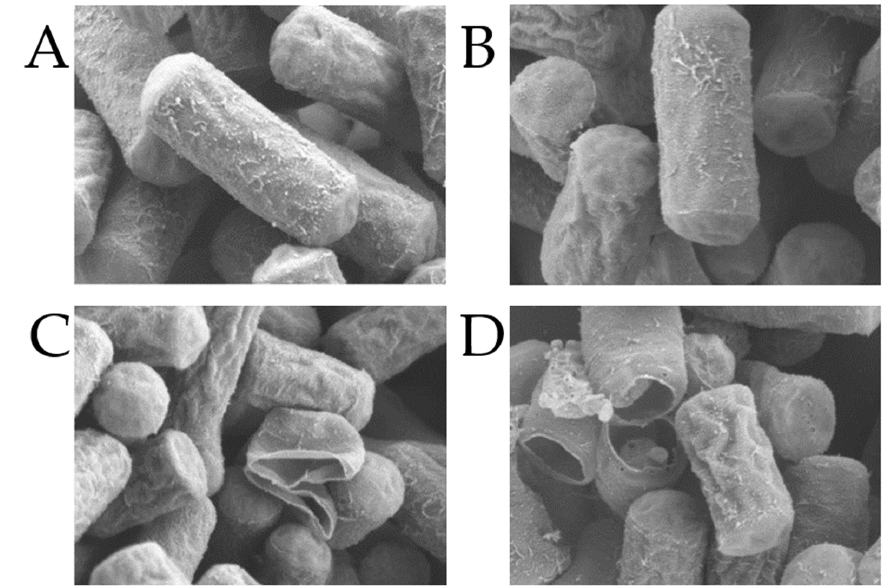
Figure 2. Scanning electron micrographs of C. perfringens at different CA–MA concentrations. ( A ) blank control; ( B ) 132.5 μ g/mL; ( C ) 265 μ g/mL; ( D ) 530 μ g/mL.